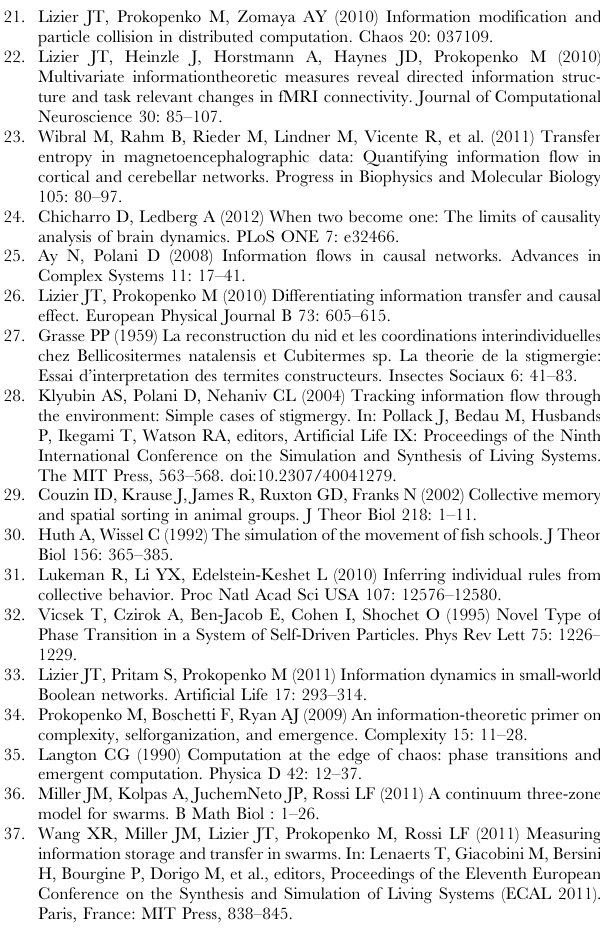
configuration; each square is 28 | 28 in size. The top panel shows the overall TE as depicted in Figure 4 in the main text, with the vertical line highlighting the specified time. The bottom panel shows the swarm dynamics at the specified time, the individuals’ two-dimensional positions are plotted on the x and y axes, with the colours of each individual denoting the value of its local AIS. The local AIS values for each individual is shown here in different colours, according to the scale on the right. Note the colours are scaled differently for positive and negative